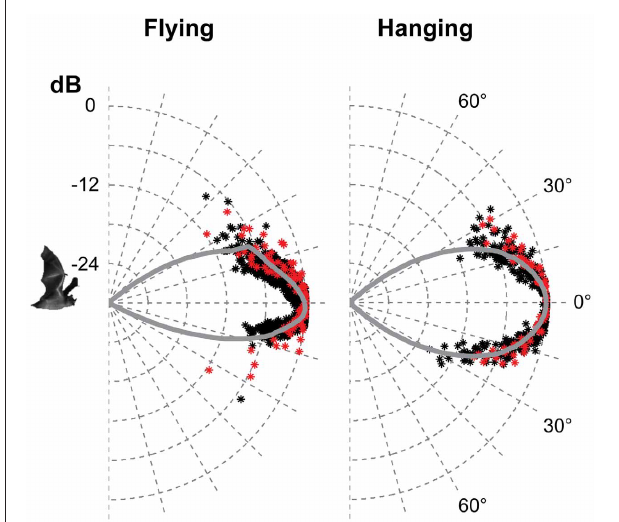
FIGURE 4 | The vertical directionality when flying and hanging. The data are from the two bats recorded in 2012, red for one bat and black for the other. Each point is the normalised amplitude in that direction. The curves are the average of the measured values pooled in 1 ◦ bins and extrapolated using a fitted second order polynomial. The beam was symmetrical in the vertical direction when hanging with HAM of 18 ◦ . When flying, the beam was more directional than when hanging, and asymmetrical with HAM in the upwards direction of 15 ◦ and 12 ◦ in the downward